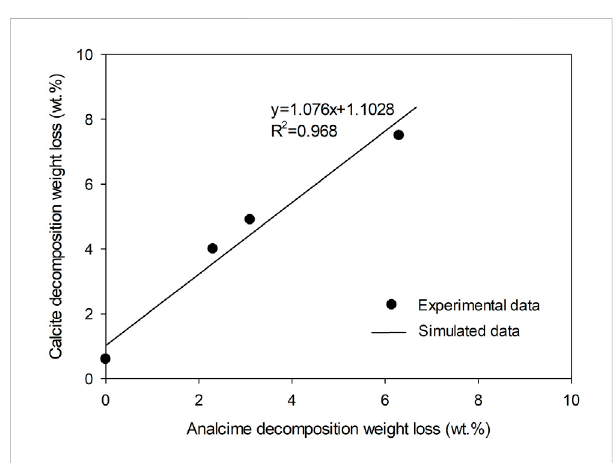
FIGURE 11 Apotentialrelationshipbetweencalciteandanalcimegeneration indicated by the weight loss due to calcite and analcime decomposition during TG measurement of the solid samples collected after reaction in NaHCO 3 solution at 200 ° C – 300 ° C for 5 – 10